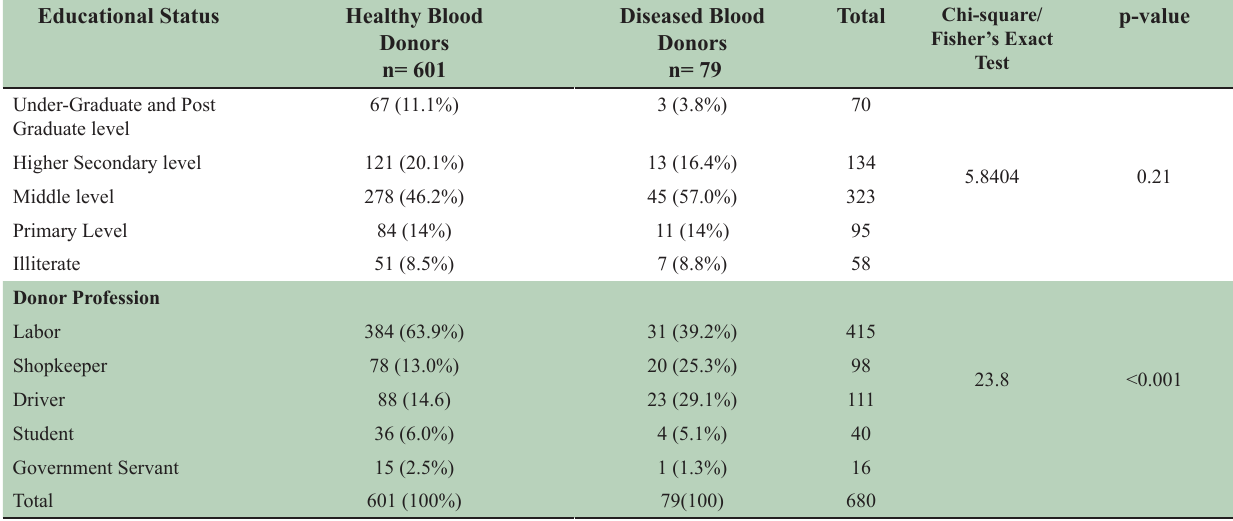
Table-IV: Socio-demographic characteristics of blood